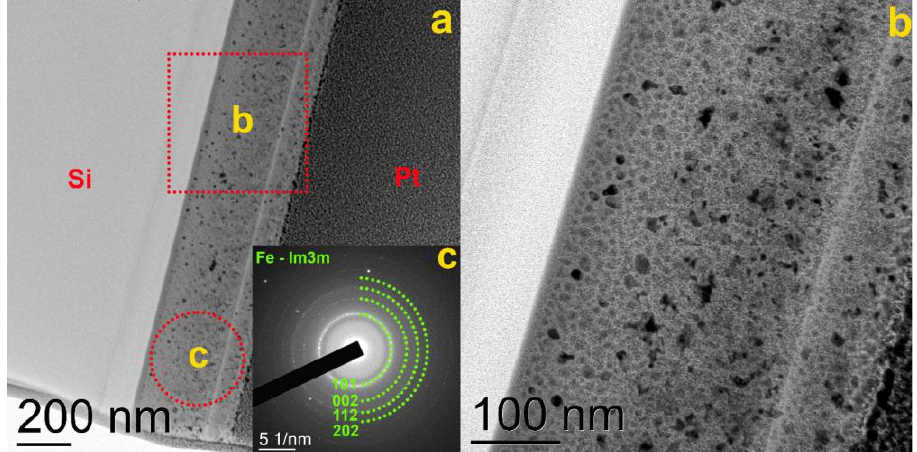
Figure 3. ( a ) TEM image of a metglas-on-silicon film produced at the first stage of the technology improvement; ( b ) enlarged lamella area; ( c ) SAED image with the specified SAED acquisition